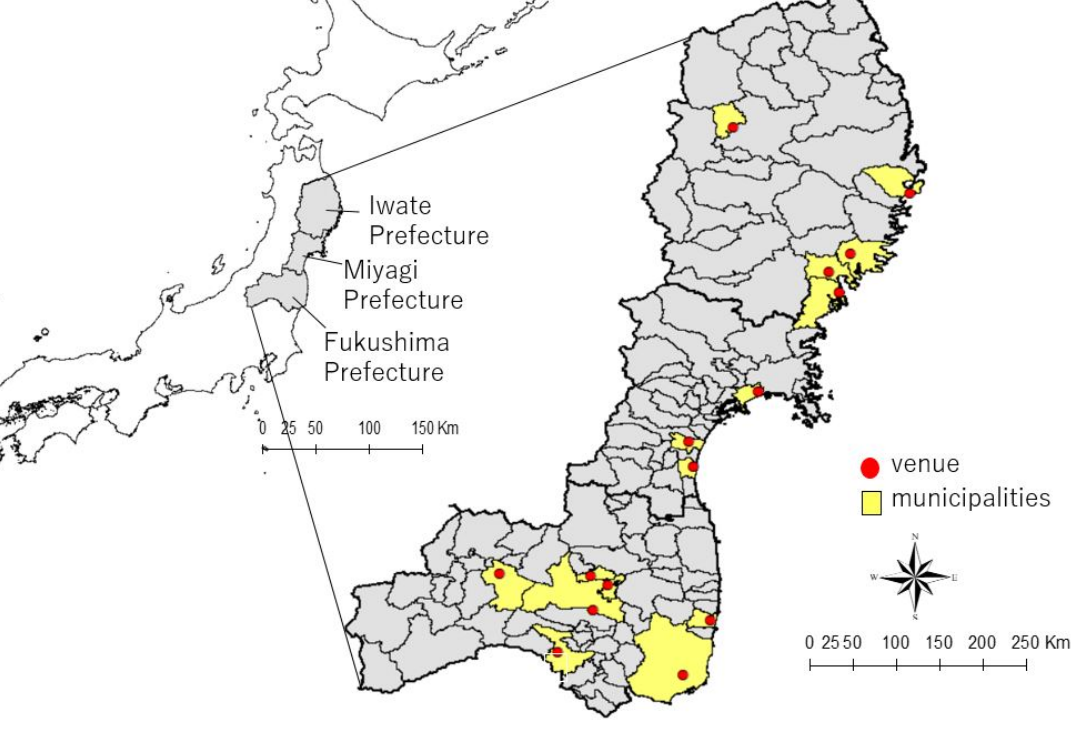
Figure 1. Study areas where cooking classes were